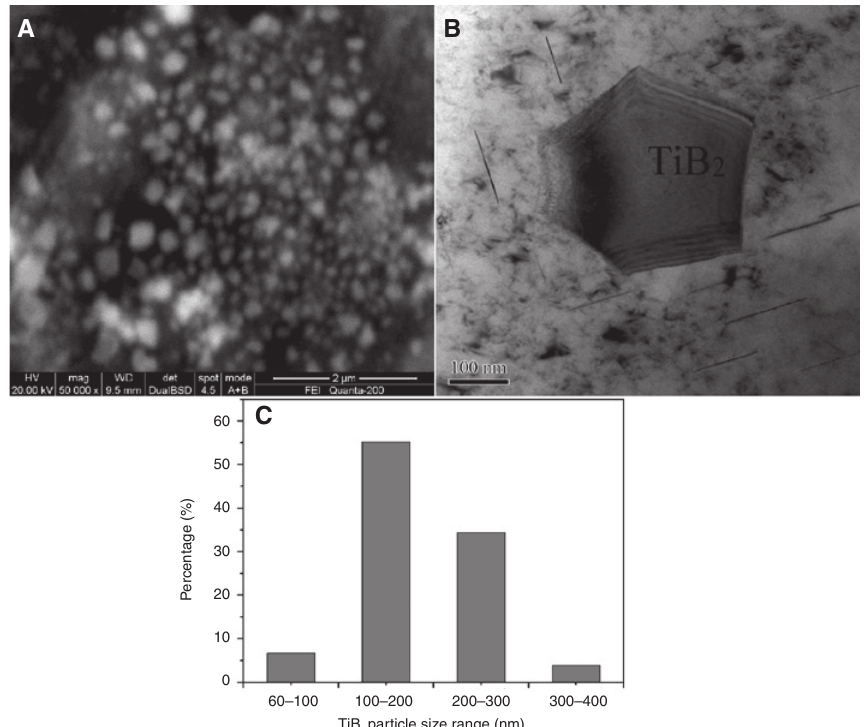
particle; (B) TEM micrographs of the TiB 2